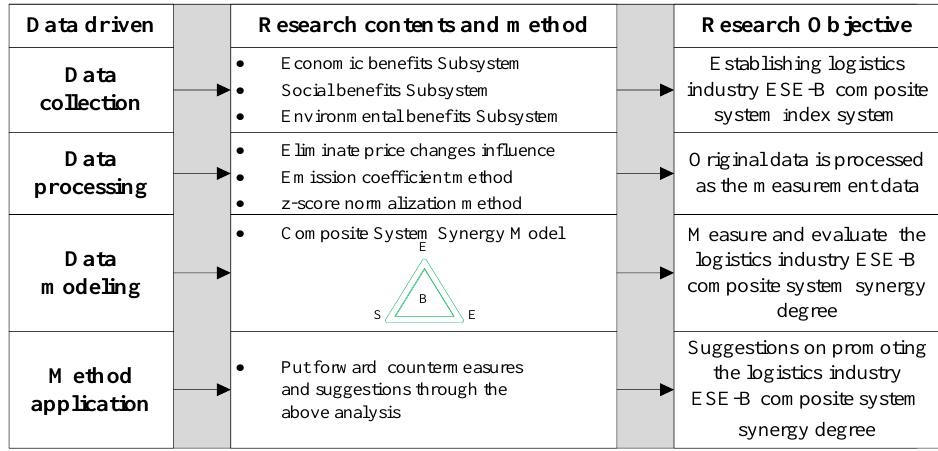
Figure 1. Research